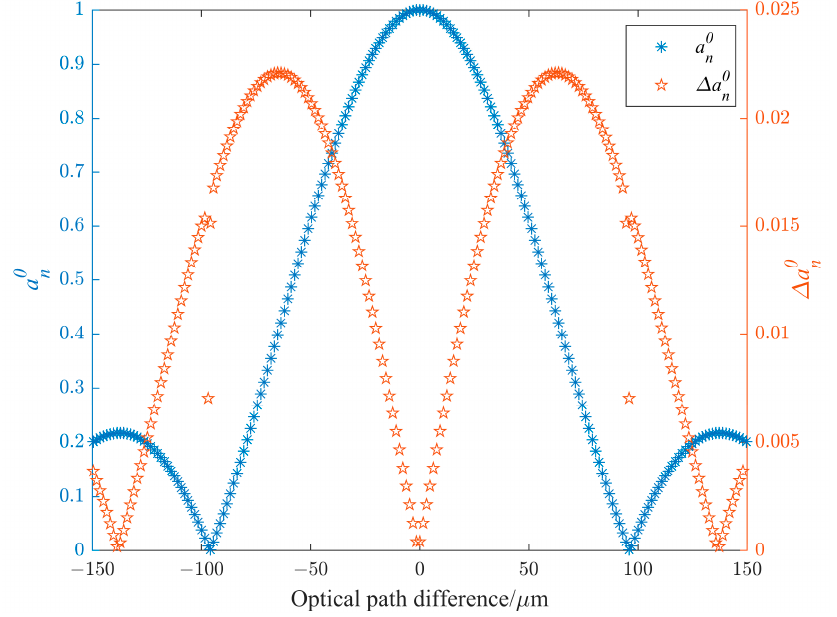
ϕ in the range of optical